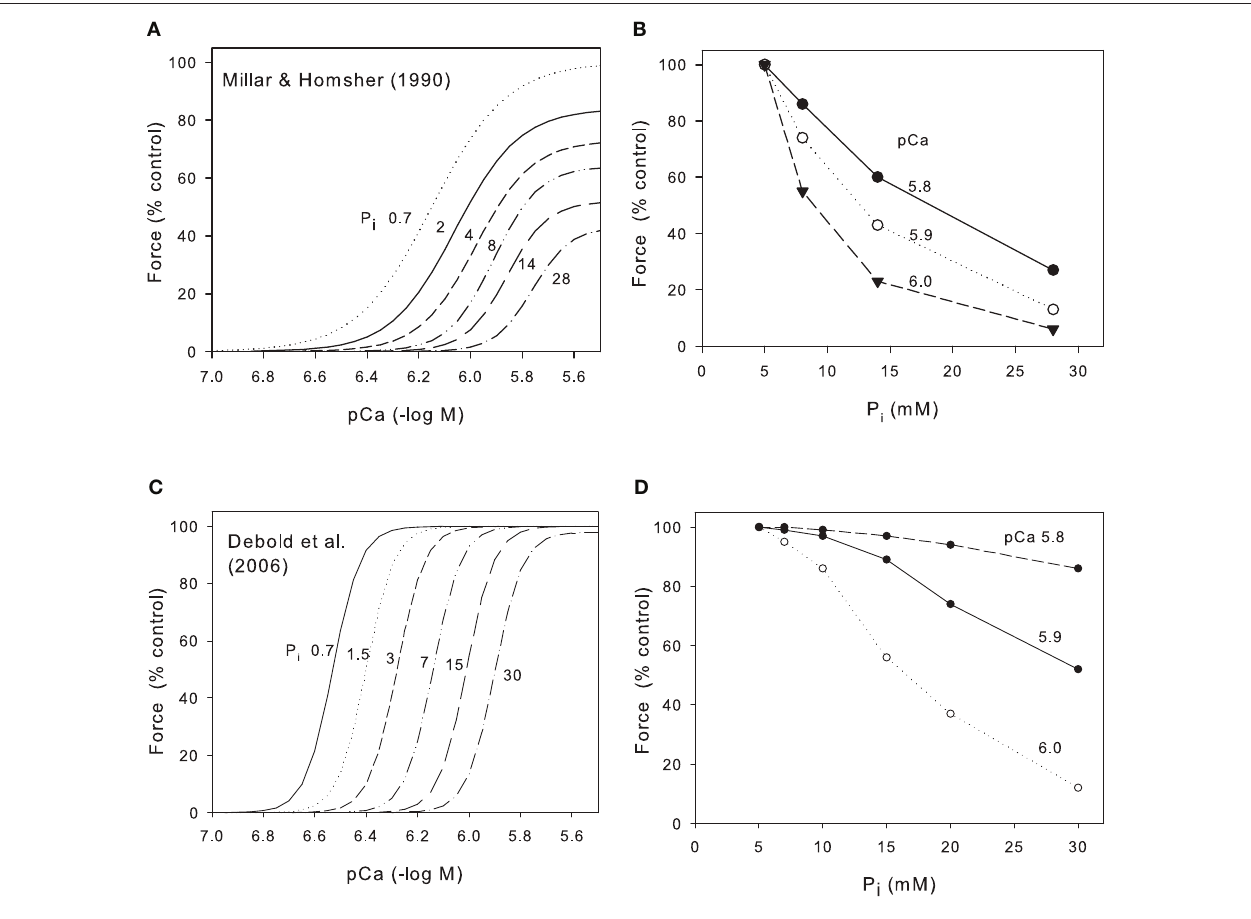
gastrocnemius muscle at 30 ◦ C (Debold et al., 2006). Published data were at 0.7mM (no added P i ) and 30mM P i ; we have interpolated curves on the basis that pCa50 is a logarithmic function of P i . Note the absence of significant effect of P i on maximum Ca 2 + -activated force under these conditions and that the Debold et al. data is much steeper; Hill coefficients ∼ 8 whereas for Millar and Homsher (1990) Hill coefficients were 2–6. (D) Data from Debold et al. (2006) redraw to show force as a function of P i at various pCa